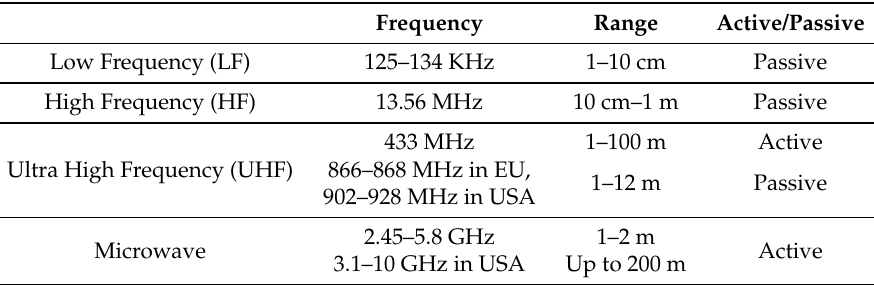
Table 1. RFID Frequencies.